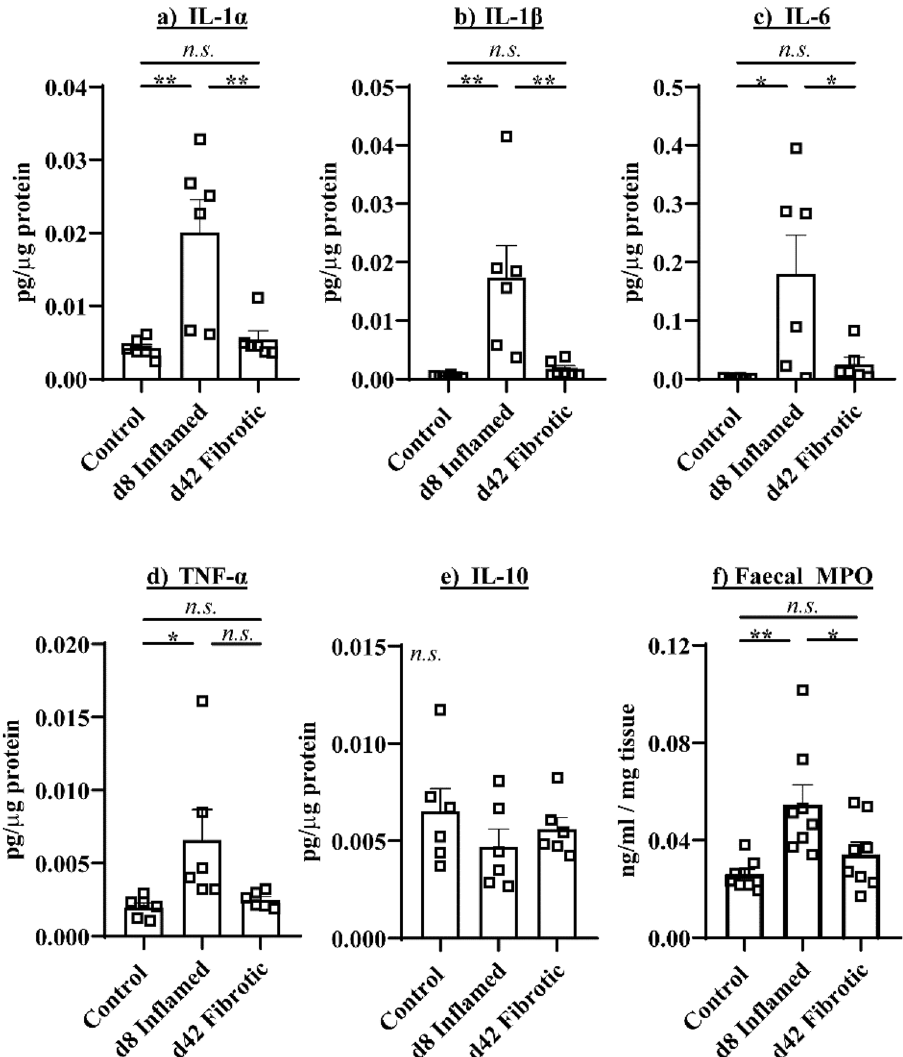
Figure 2. Innate immune mediators are not altered in colonic fibrosis. ( a ) Colonic concentrations of ( a ) IL-1α, ( b ) IL-1β, ( c ) IL-6 and ( d ) TNF-α were increased in inflamed but not fibrotic colons, as are ( f ) fecal MPO concentrations, while ( e ) IL-10 concentrations were not altered in inflamed or fibrotic mice. * P < 0.05, ** P <